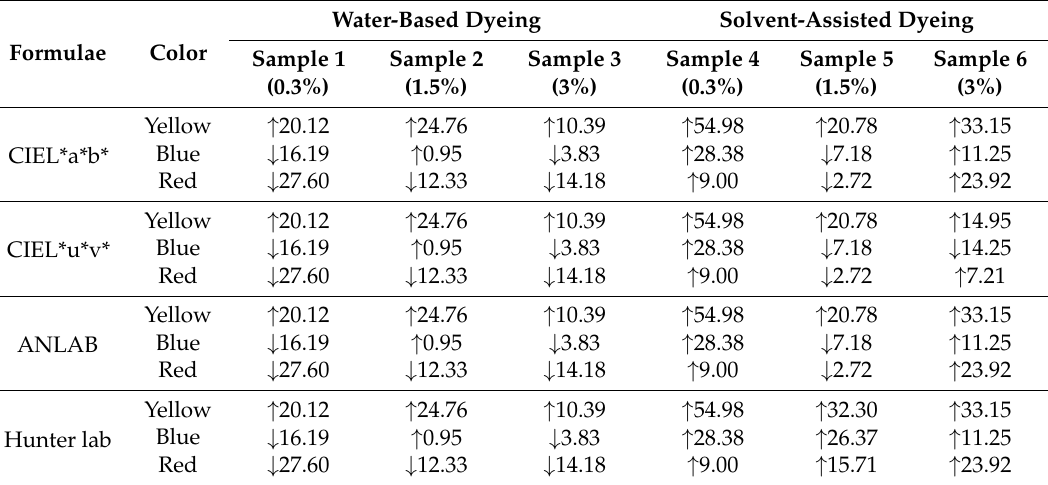
Table 9. Color matching percentage (%) difference of standard samples from water-based and solvent-assisted dyeing with different